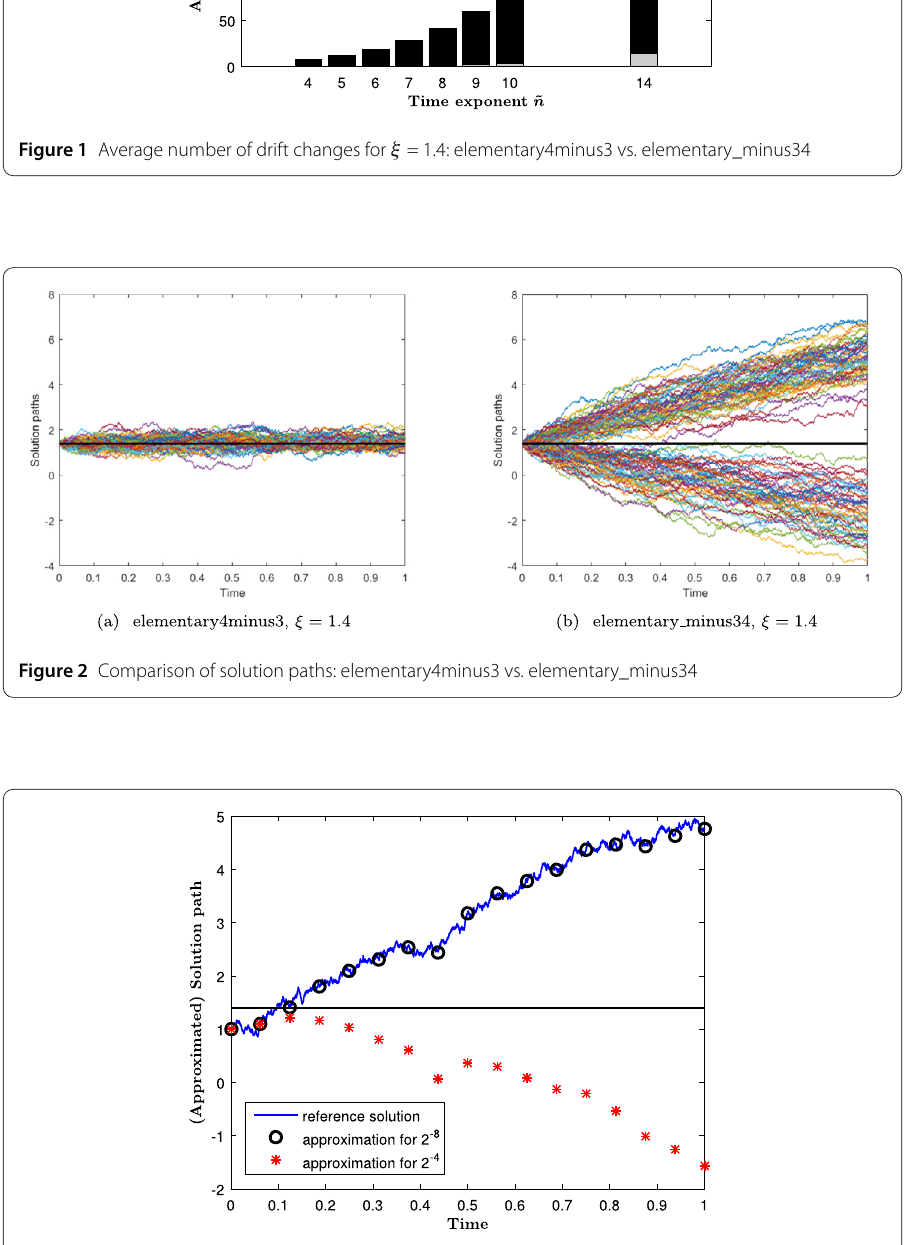
Figure 3 Importance of capturing the drift changes for elementary_minus34, ξ =